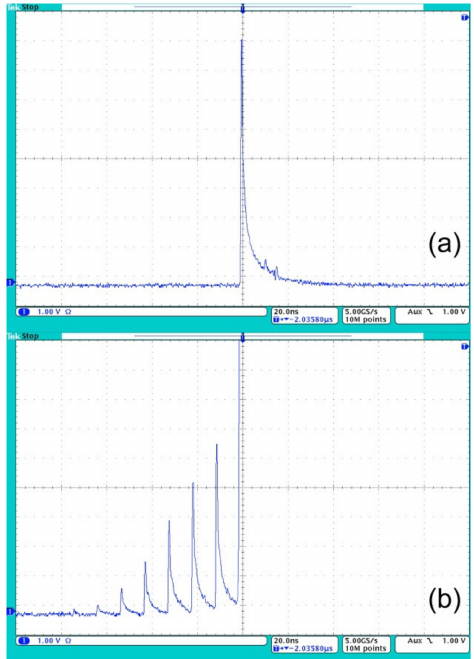
Figure 8. Waveforms of output picosecond pulses at the laser output: ( a ) Main picosecond pulse, registration sensitivity is attenuated by 2 × 10 3 using an additional neutral filter NG-10, ( b ) Residual pre-pulses in the laser output beam without an additional neutral filter. The oscilloscope sensitivities in ( a , b ) are the